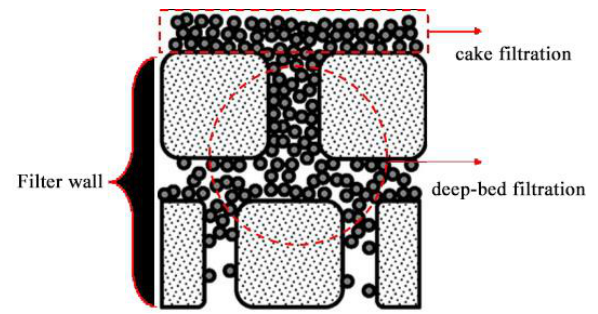
Fig. 1. Schematic diagram of DPF filtration phase.